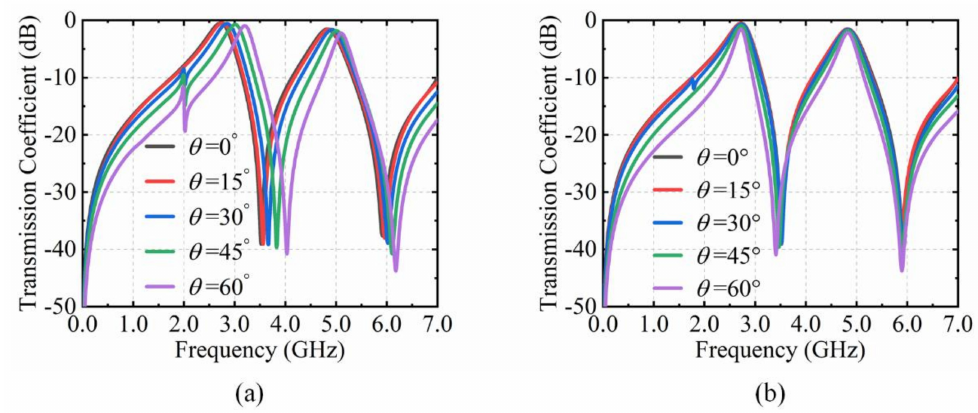
Figure 6. CST simulation results of the proposed structure. ( a ) Transmission coefficient with incidence angles from 0 ◦ to 60 ◦ . ( b ) The effect of angular dispersion compensation with incidence angles from 0 ◦ to 60 ◦ .